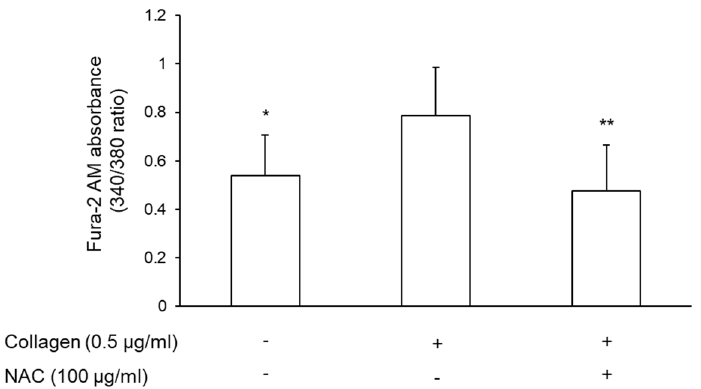
Figure 7. Effect of NAC on intracellular calcium mobilization. PRP was incubated with 2 μM Fura-2 AM. Platelets were precipitated and resuspended in plasma pre-treated with vehicle or NAC for 30 min at 37 °C. Platelets were stimulated with collagen (0.5 μg/mL) for 6 min. Data are expressed as absorbance of Fura-2 AM, n = 4. * p < 0.05 and ** p < 0.01 vs. collagen-stimulated platelets for ANOVA and Dunnett’s post hoc test.